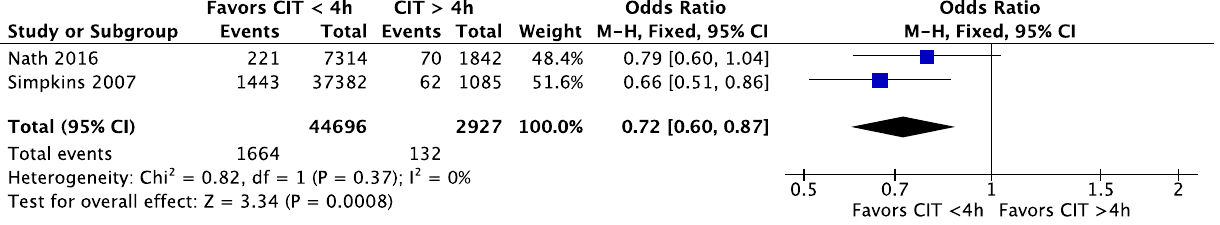
Figure 5. One-year graft survival for CIT shorter and longer than 4 h. CIT: cold ischaemia time.